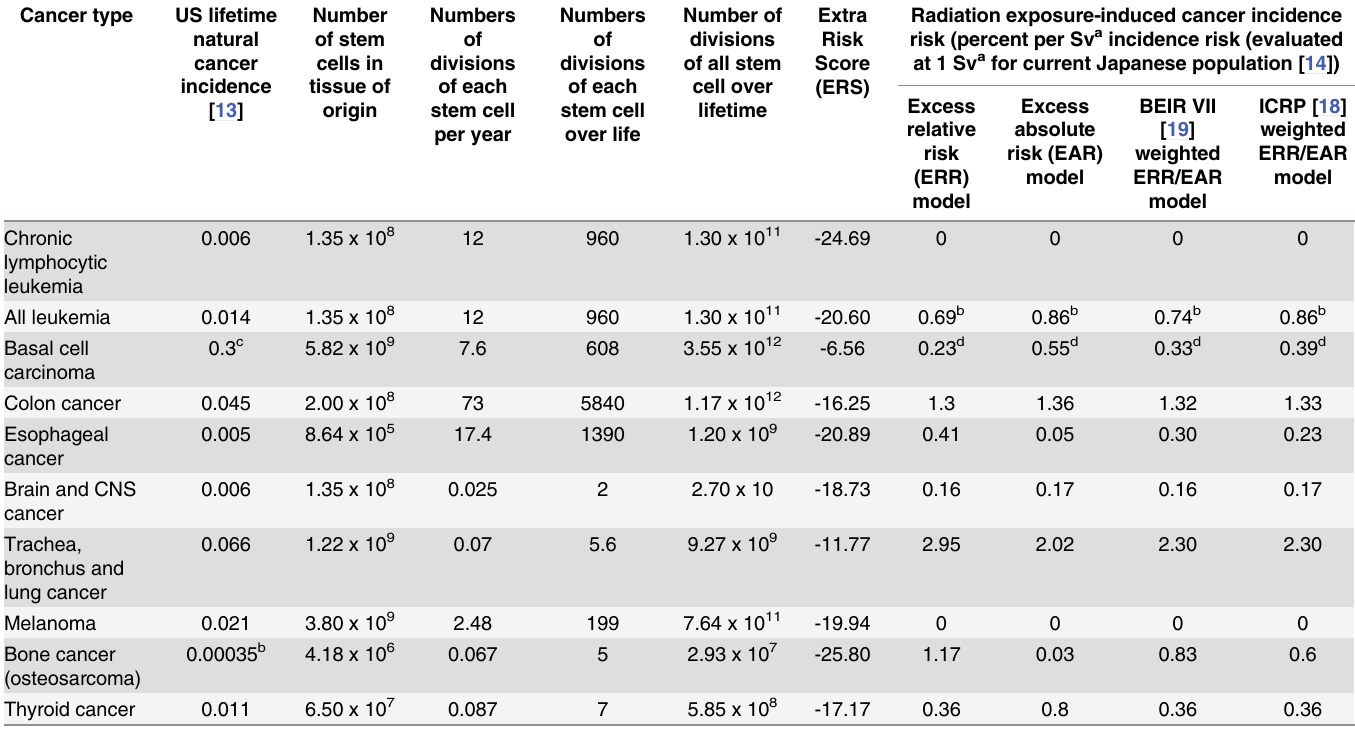
Table 1. Summary data on radiation-associated cancer risk and various tissue parameters, reproduced in part from Tomasetti & Vogelstein [2] and UNSCEAR [unless otherwise indicated taken from Table 70 in Annex A of [14]] Cancer